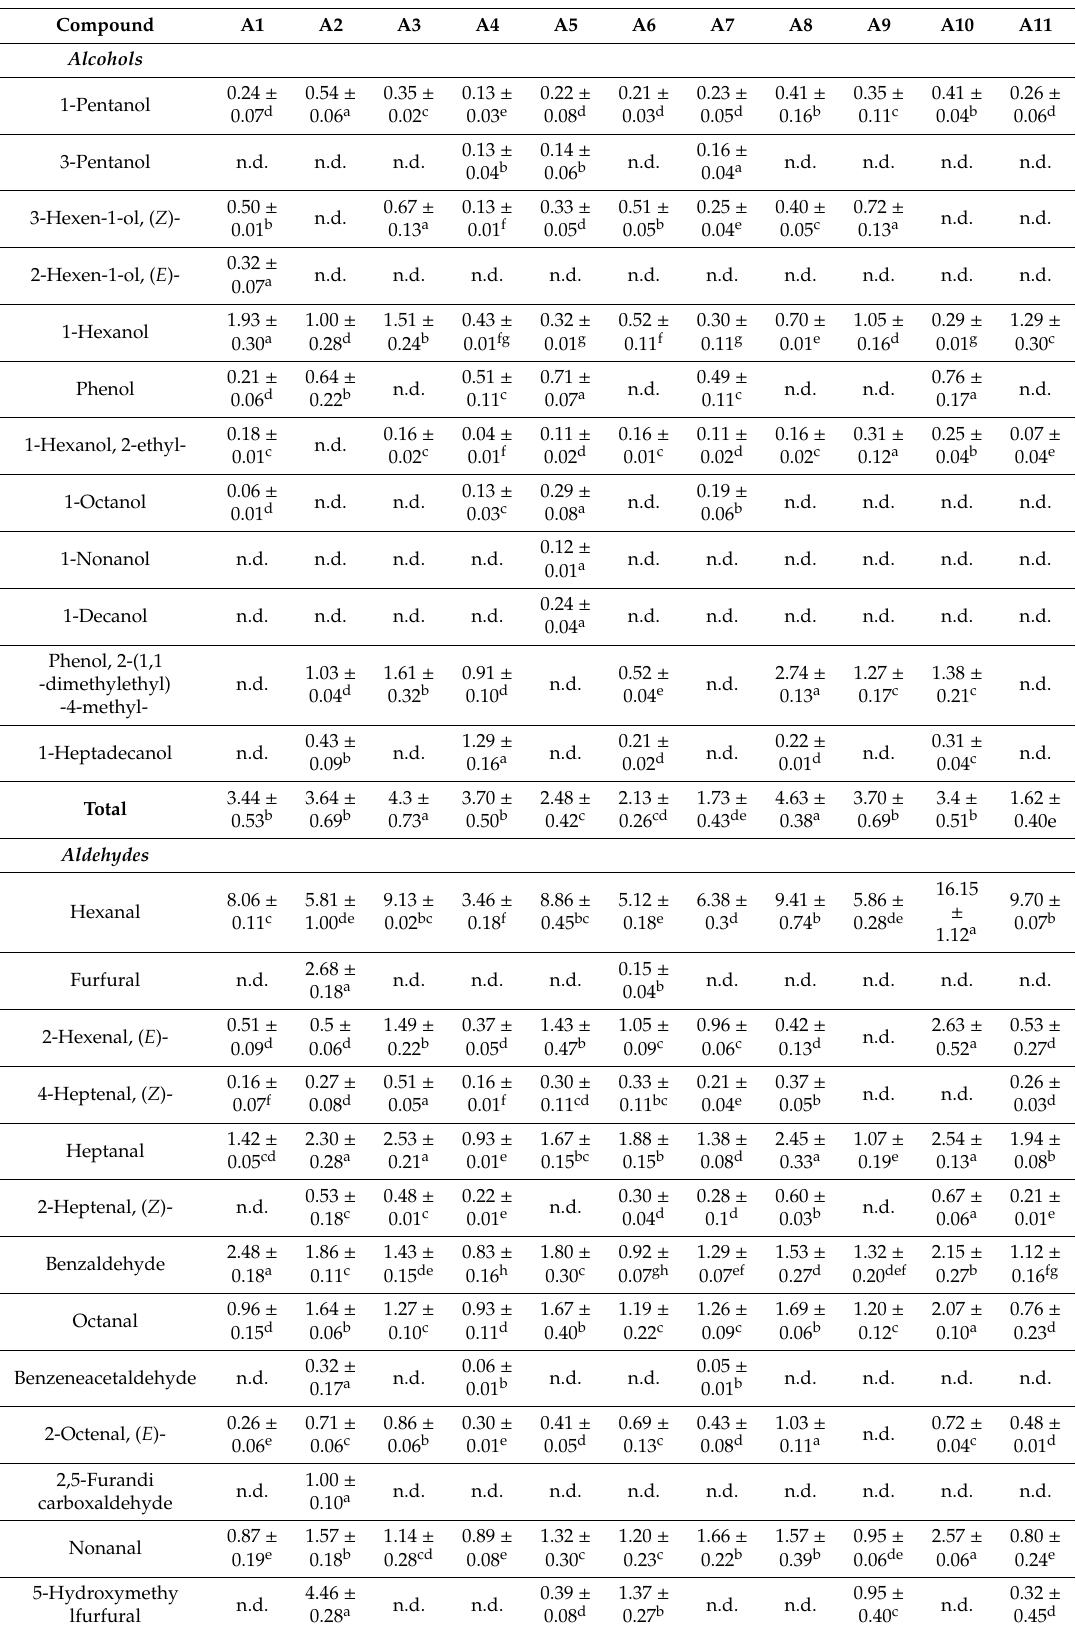
Table 4. Composition of volatiles in the 11 apricot cultivars